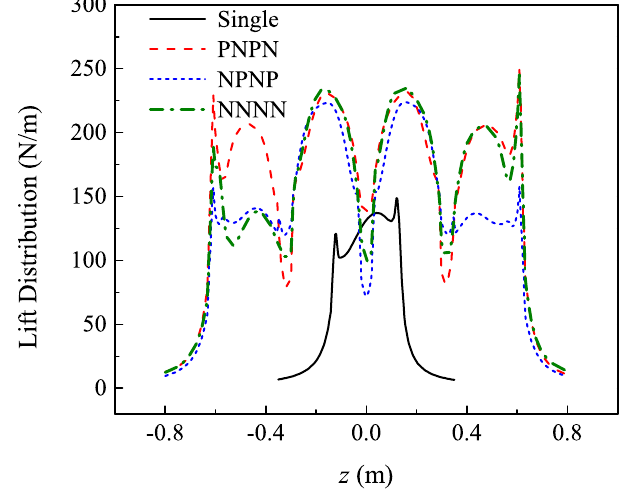
Figure 16. Lift distribution of the channel wing.